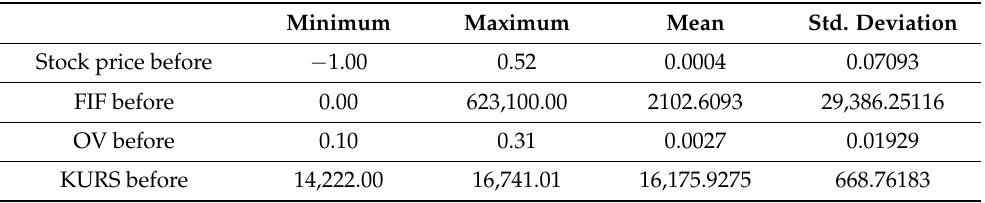
Table 6. Descriptive Statistics before